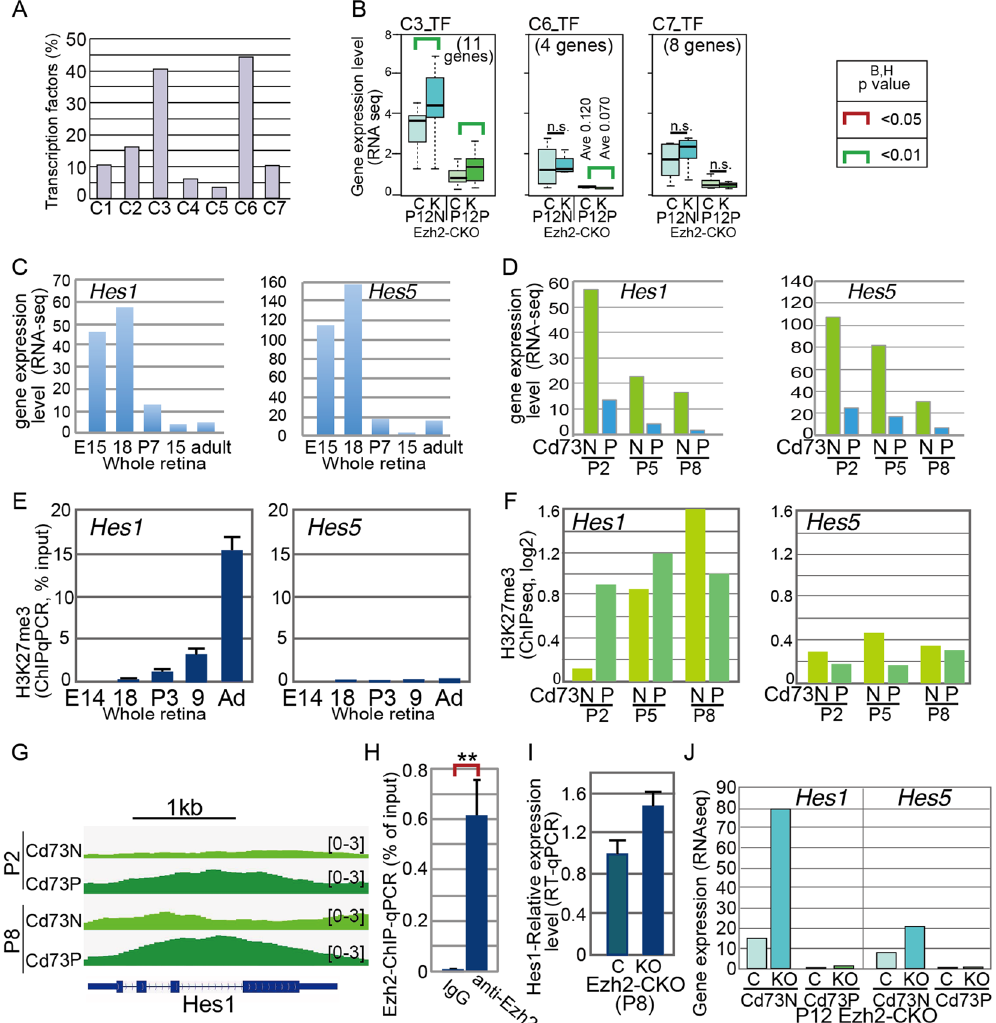
Figure 5. Molecular signature of Hes1 and Hes5 genes. ( A ) Percentage of genes categorized to transcription factors by IPA in total number of genes in the clusters is shown. ( B ) Box plots of average levels of transcription factors in each cluster of RNA-seq data of Ezh2-CKO retina 3 . Retinas from ( C ), control mouse; K, Ezh2-CKO mouse were 13 used. P12N, Cd73 negative population at P12; P12P, Cd73 positive population at P12 retinas. ( C ) Expression of Hes1 and Hes5 transcripts during mouse retinal development examined by RNA-seq 13 are shown. ( D ) Expression levels of Hes1 and Hes5 transcripts examined by RNA-seq using Cd73_P and Cd73_N cell fractions in indicated developmental stages. ( E ) H3K27me3 levels at 5 ′ genomic region of Hes1 and Hes5 loci examined by ChIP-qPCR using whole retina at indicated developmental stages using primers for Hes1 and Hes5 are shown. ( F ) H3K27me3 levels of Hes1 and Hes5 loci examined by ChIP-seq using Cd73_P and Cd73_N retinal cells. ( G ) Genome browser snapshots showing the Hes1 region of log2 ratio enrichment for H3K27me3. ( H ) ChIP-qPCR of anti-Ezh2 antibody of retinal cell extract from control mice. ( I ) The expression level of Hes1 in retina of Ezh2-CKO 3 at P8 examined by RT-qPCR. ( J ) The expression level of Hes1 and Hes5 in Cd73 positive and negative population in retina of Ezh2-CKO at P12 examined by RNA-seq. E, embryonic day; P, postnatal day; N, negative; P, positive. H; The experiments were done three times, and values are average of three samples with standard deviation. p value; ** < 0.01 was calculated by Student’s